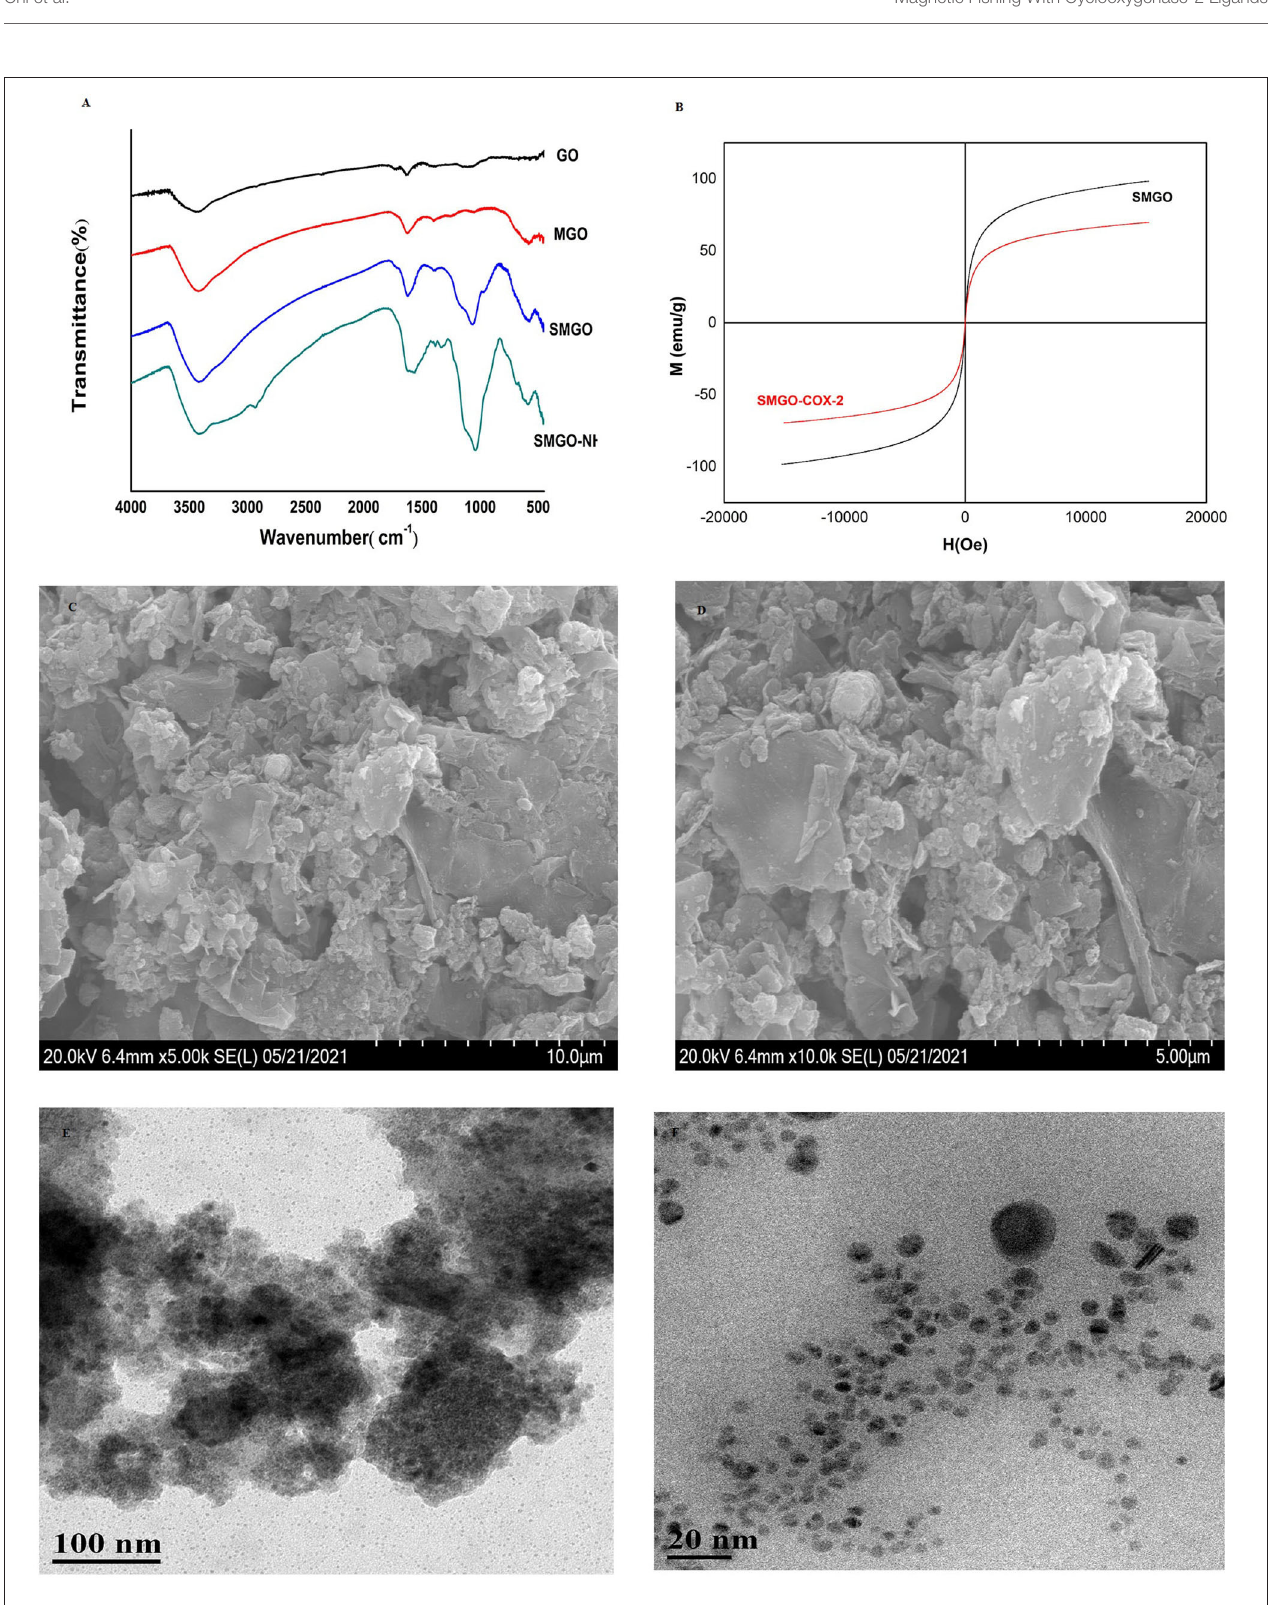
FIGURE 1 | (A) Fourier-transform infrared (FT-IR) spectra of GO, MGO, SMGO, and SMGO-NH2. (B) Magnetization curves of SMGO, SMGO@COX-2. (C,D) SEM images of SMGO@COX-2; (E,F) TEM images of SMGO@COX-2.